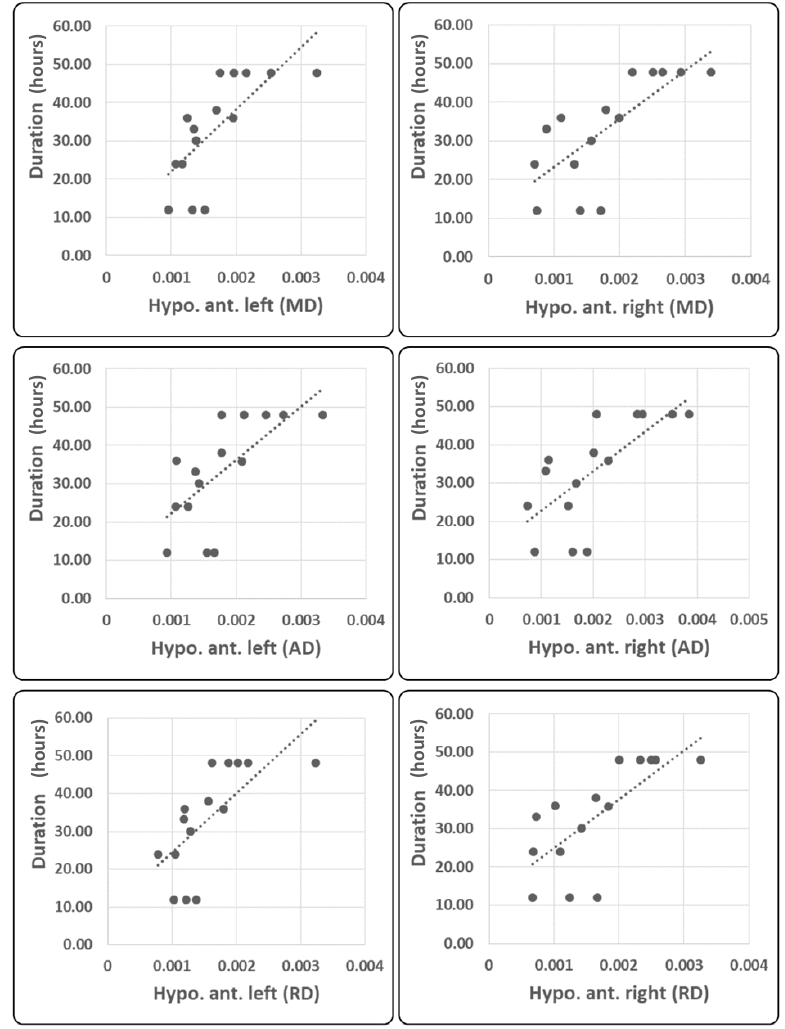
Figure 5. Linear regression analysis between duration of migraine attacks in hours and bilateral anterior hypothalamic MD, AD, and RD values.